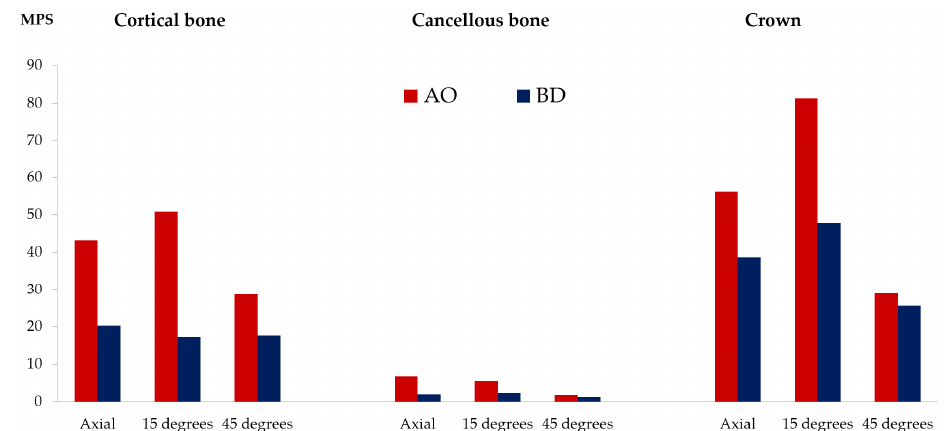
Figure 8. Maximal principal stress (MPa) results from cortical bone, cancellous bone, and crown.